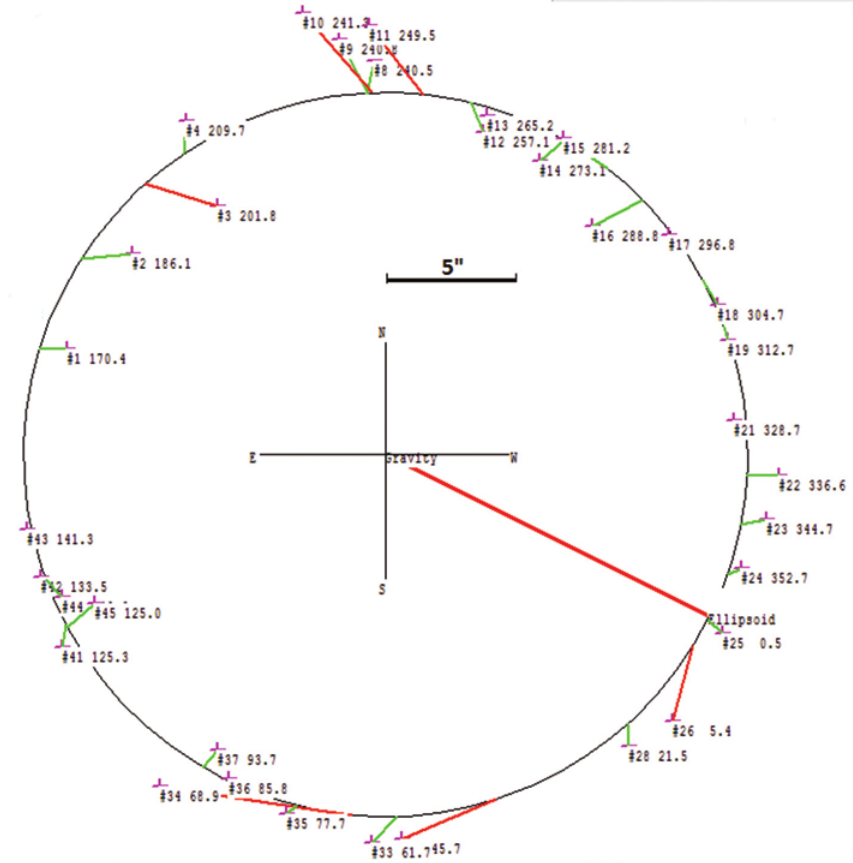
Fig. 6. Observed differences between directions of plumb line and reference ellipsoid’s normal in rotating coordinate system. The red radius represents position when Y axis points to South